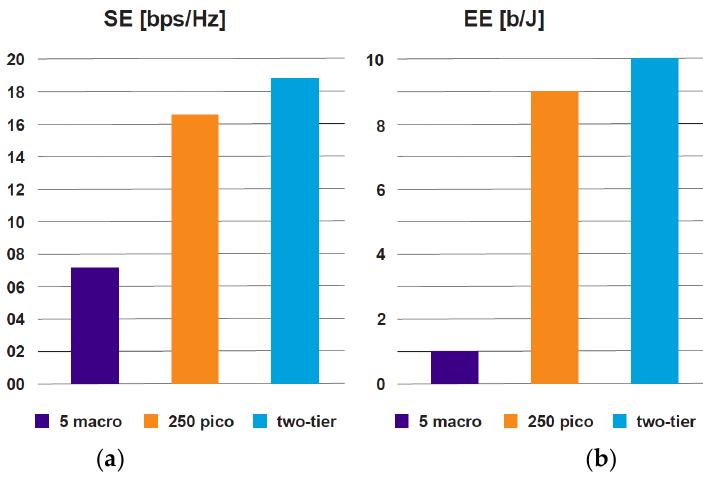
Figure 7. Simulation results for: ( a ) SE and ( b ) EE.